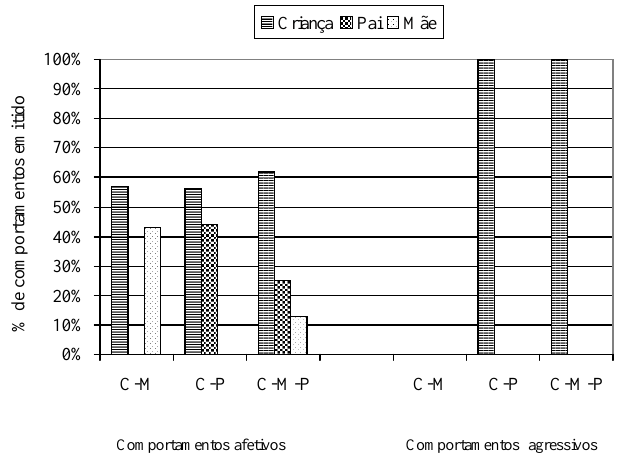
Figura 4. Membros familiares responsÆveis pela emissªo de comportamentos afetivos e agressivos, durante epis(cid:243)dios de intera(cid:231)ªo diÆdicos e triÆdicos. foram os pais que emitiram mais freq(cid:252)entemente comportamentos afetivos que as mªes. Por outro lado, nªo foi observada a emissªo de comportamentos agressivos nem pela mªe, nem pela crian(cid:231)a durante as intera(cid:231)ıes C-M.